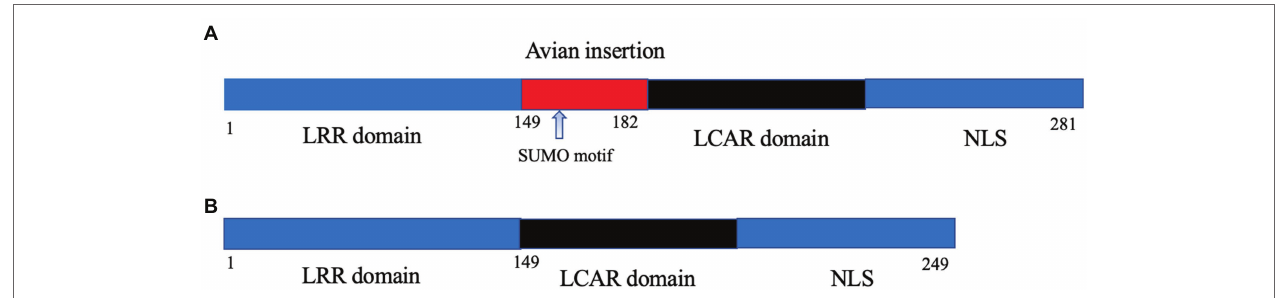
FIGURE 1 | Schematic illustration of chicken (A) and human ANP32A (B) . The avian-specific 33-amino acid insertion is highlighted in red with the containing SUMO binding motif being indicated by an